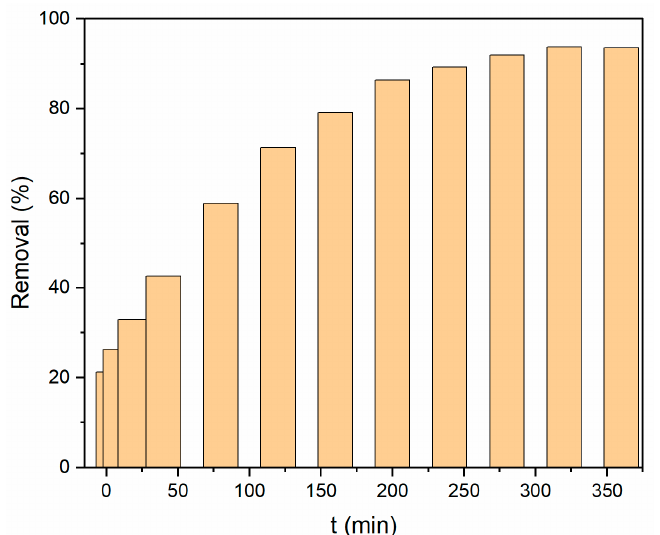
Figure 5. Adsorption percentages increase with time in a dispersion of 2.0 g of FeOH-Vt in 200 mL